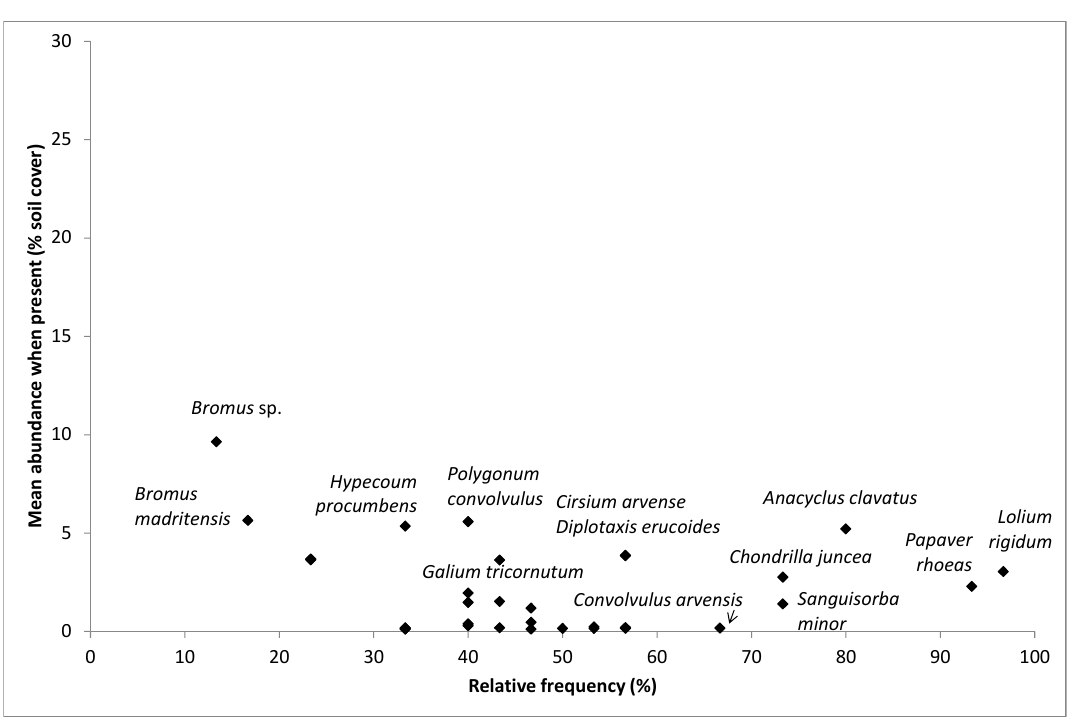
Figure 6. Species relative frequency and mean abundance when present in sainfoin fields in their second year of establishment (S2). Data of years 2011–2014 pooled together. Named species are the most abundant and most frequent ones.